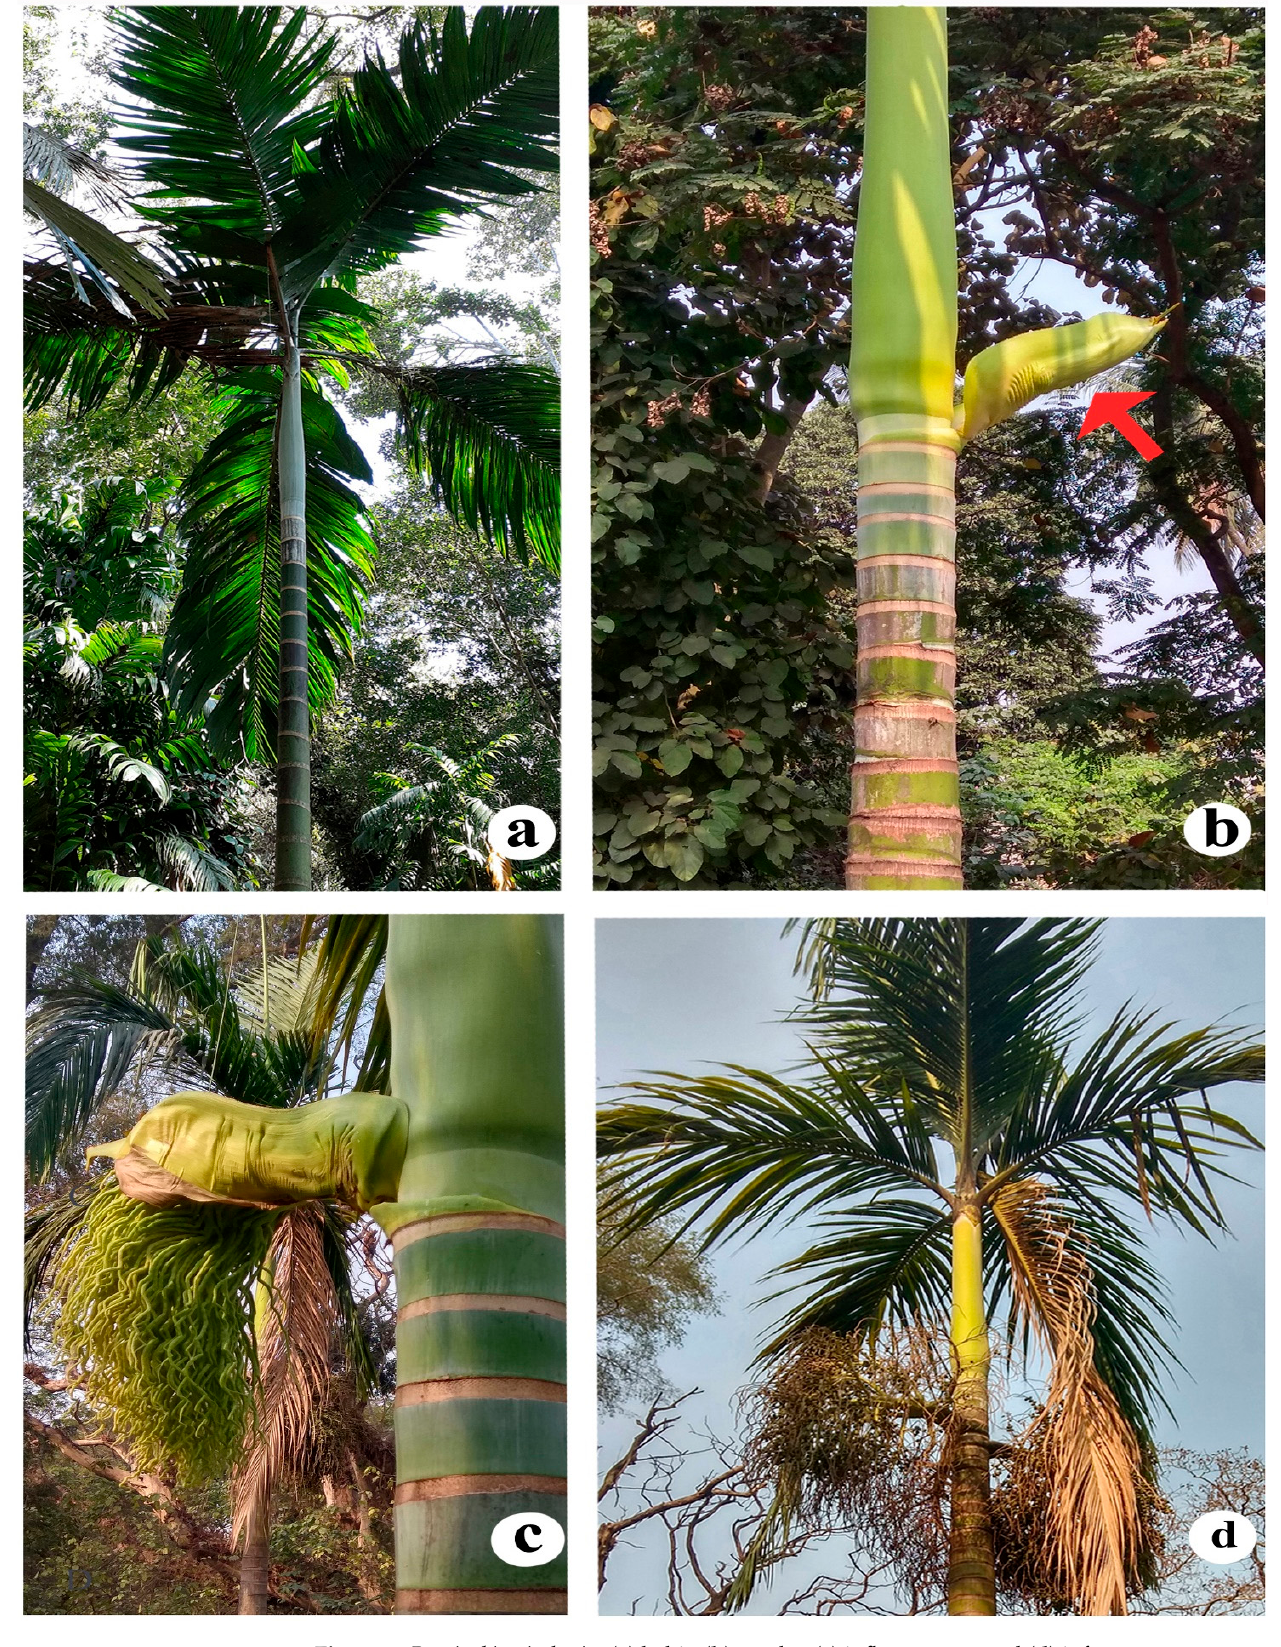
Figure 2. Bentinckia nicobarica ( a ) habit, ( b ) spathe, ( c ) inflorescence, and ( d ) infructescence.